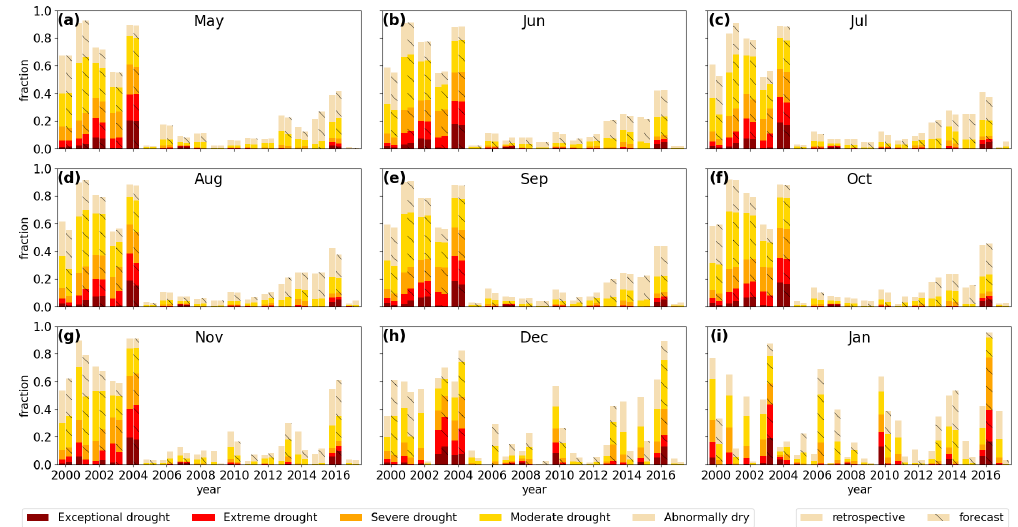
Figure 13. Same as Fig. 12 but for the Helmand